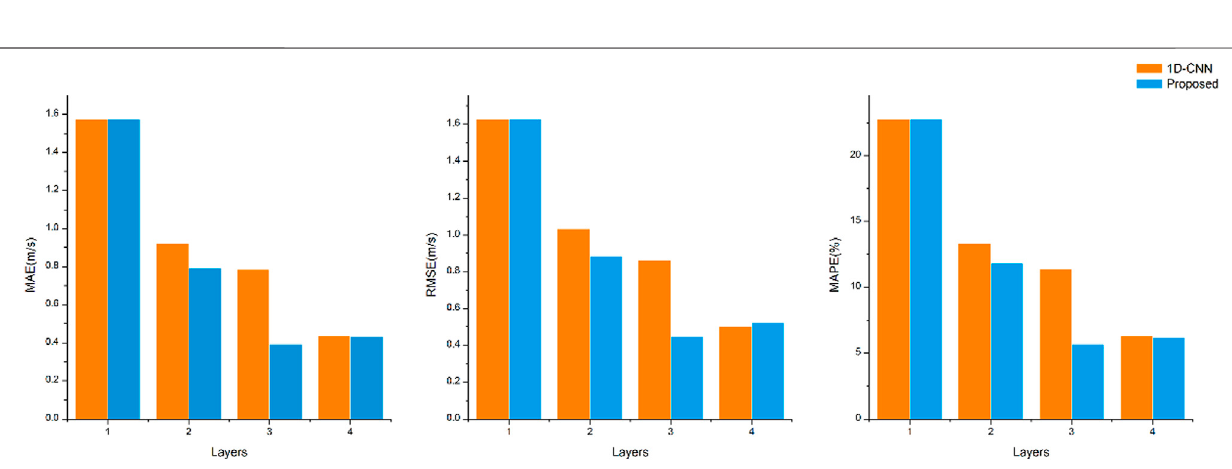
Frontiers in Earth Science |